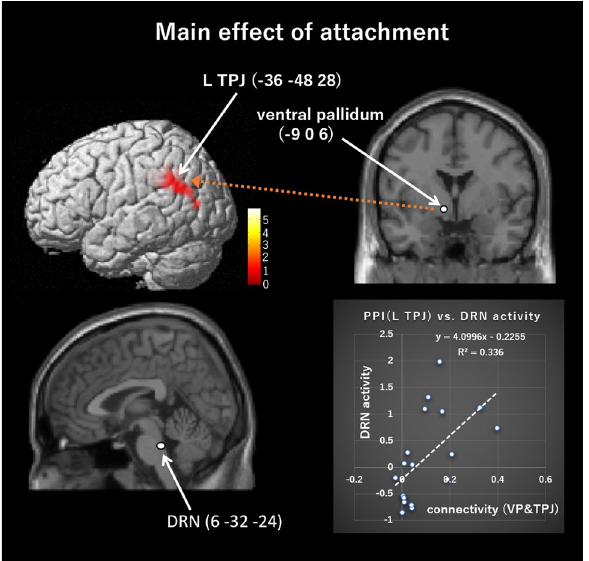
Figure 4. A positive connectivity between the left VP (− 9, 0, 6) and the left temporoparietal junction (TPJ; − 36, − 48, 28) was observed in the main effect of attachment, and its individual strength positively correlated with individual activity in the dorsal raphe nucleus (DRN; 6, − 32, − 24).